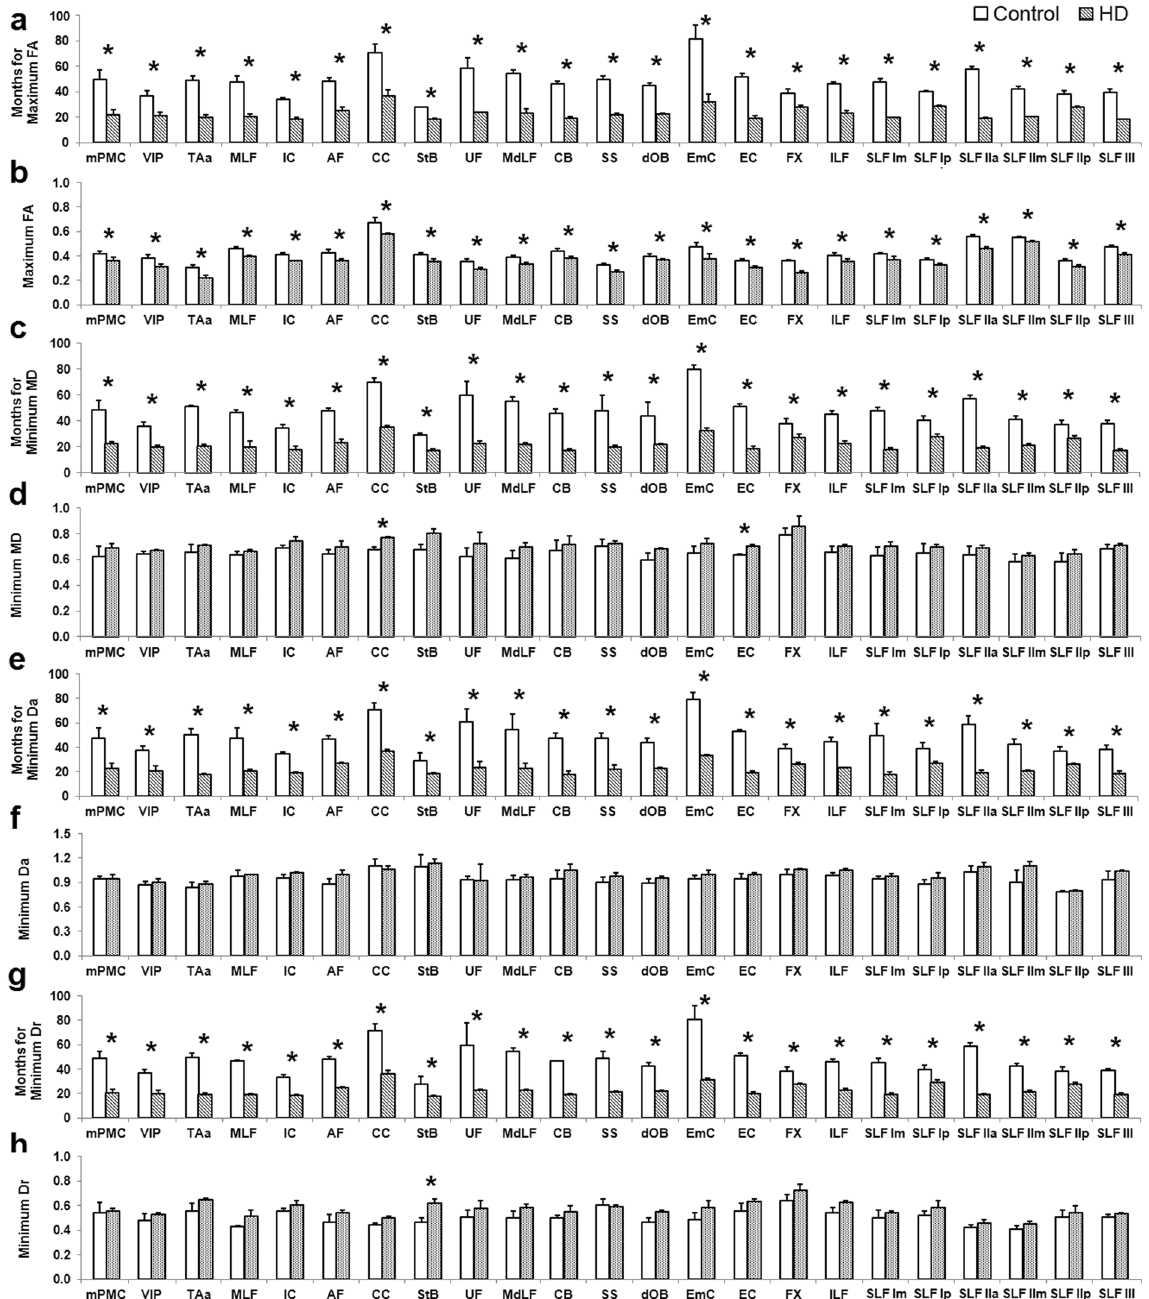
Figure 3. A graphical representation of the age (months) for the minimum/maximum DTI-derived measures ( a , c , e , g ), and for the minimum/maximum DTI-derived measures ( d , f , h ; unit: 10 − 3 mm 2 /s) averaged across all ages for each ROI. Details are shown in Tables 1 and 2. The star ( * ) indicates significant group difference with FDR correction (q = 0.05). FA: fractional anisotropy; MD: mean diffusivity; Da: axial diffusivity; Dr: radial diffusivity. Note that for Fig. 3(a,c,e,g), the y-axis value represents the age (months) predicted by the Poisson model and thus could exceed the actual age range of the animals used in the study (48